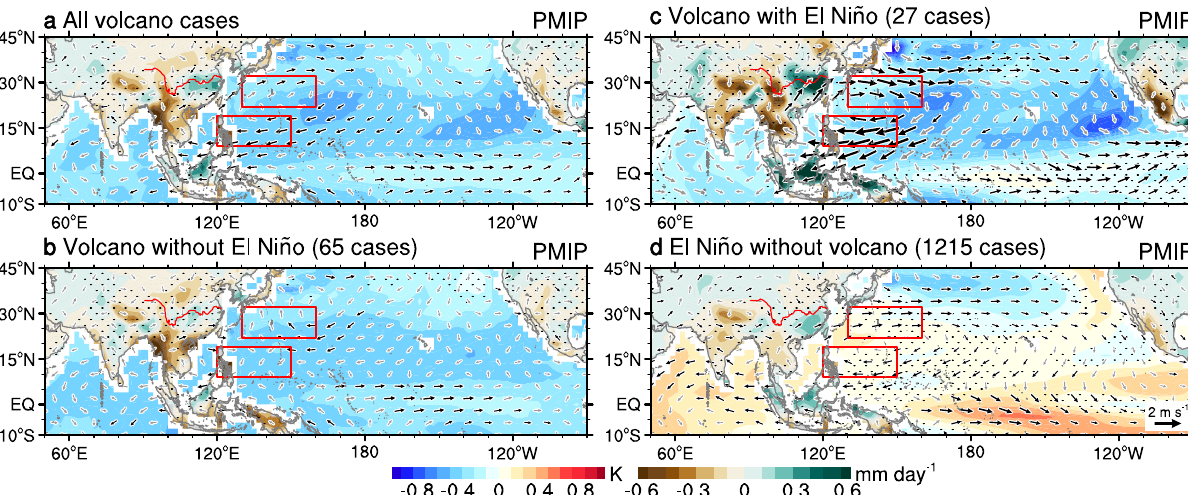
Fig. 3 Simulated EASM-ocean responses to tropical eruptions. Composite SST anomalies (shading over ocean), precipitation anomalies (shading over land), and 850 hPa wind anomalies (vectors) in the fi rst boreal summer after a all 92 simulated tropical eruptions, b 65 eruptions without, and c 27 eruptions with an El Niño response in the fi rst boreal winter after the eruption, as well as d composites for 1215 non-volcanic El Niños in 13 PMIP last millennium simulations from 1470 to 1849 AD. Stippling and gray vectors indicate precipitation and temperature anomalies and wind anomalies not signi fi cant at the 90% con fi dence level, respectively. The red curve is the Yangtze River. The red rectangles denote the locations where the EASM circulation index is de fi ned: the 850 hPa zonal wind averaged in the southern box minus that in the northern box (see “ Methods ” ). A negative value of this index represents enhanced Paci fi c high and associated East Asian subtropical rainfall. Maps created with The NCAR Command Language (Version 6.6.2) [Software]. (2019). Boulder, Colorado: UCAR/NCAR/CISL/TDD.